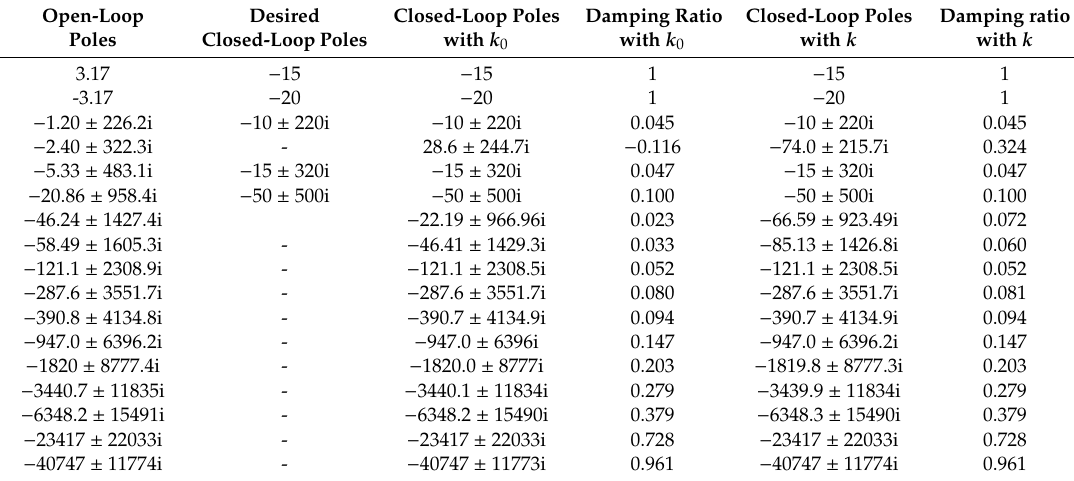
Table 9. Open-loop and closed-loop poles for the test-case